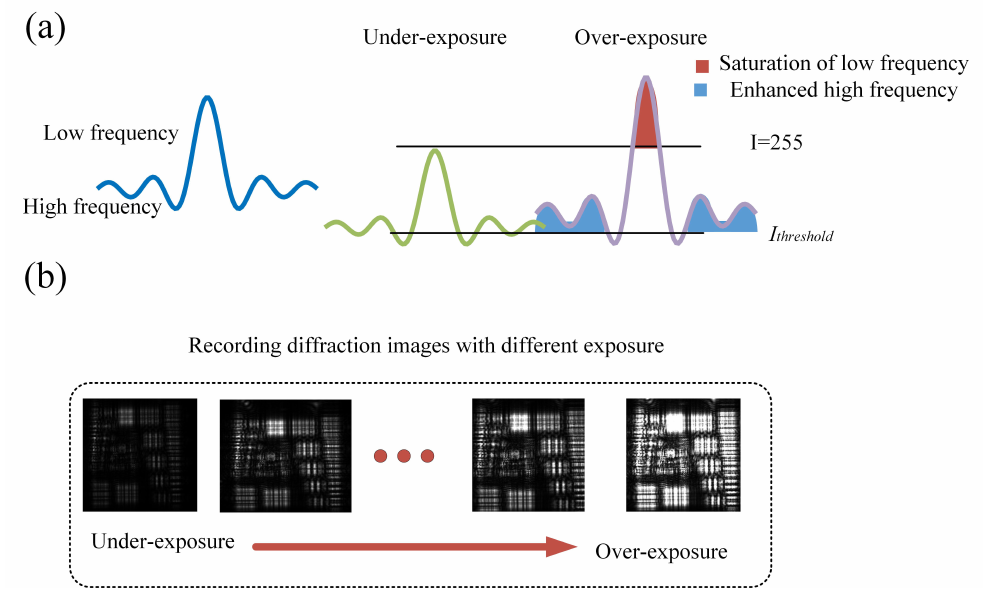
Figure 1. ( a ) The intensity distribution of the object’s high-frequency information and low-frequency information; The blue area shows the enhanced high-frequency components in an over-exposed diffraction pattern; ( b ) Acquisition of multiple diffraction patterns at different levels of